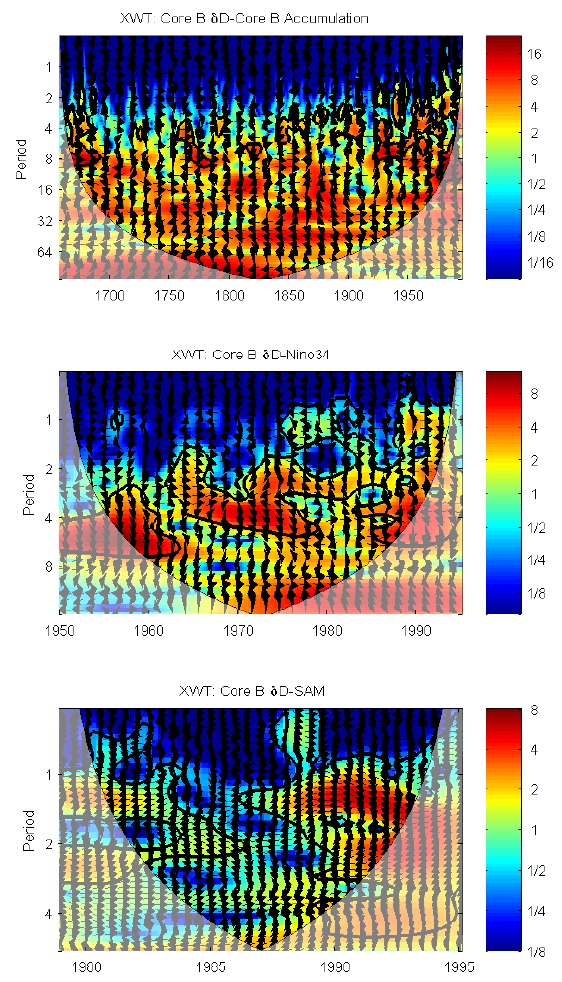
Figure 6. XWT plot of regions in time–frequency space where the time series in question show high common power. The phase arrows show the relative phasing of the time series (right: in-phase, left: anti-phase, down: X leading Y by 90 ◦ , up: Y leading X by 90 ◦ ). Figure 6. XWTplotofregionsintimefrequencyspacewherethetimeseriesinquestionshowhighcommonpower.Thephasearrowsshow Top panel: core B δ D and core B net accumulation XWT from 1657 the relative phasing of the time-series (right: in-phase, left: anti-phase, down: X leading Y by 90 o , up: Y leading X by 90 o ). Top) Core B δ D to 1995. Middle panel: core B δ D and Niño 3.4 XWT from 1950 to and Core B Net Accumulation XWT from 1657-1995. Middle) Core B δ D and Ni˜no 3.4 XWT from 1950-1995. Bottom) Core B δ D and 1995. Bottom panel: core B δ D and SAM XWT from 1979 to 1995. SAM XWT from 1979-1995. All shallow ice core XWT plots can be found in Appendix A. All shallow ice core XWT plots can be found in Appendix